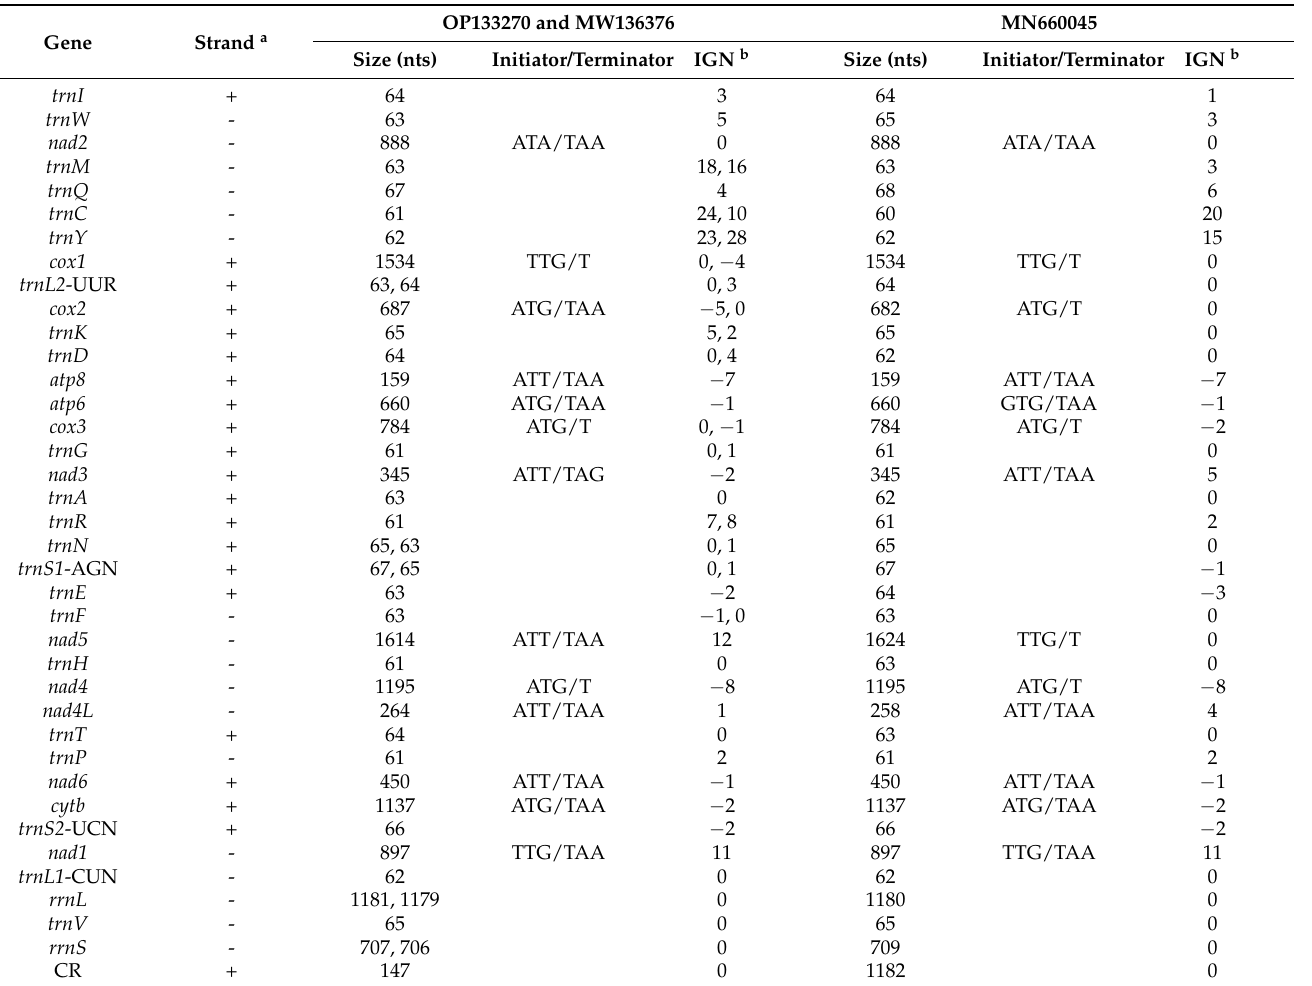
Table 1. Annotation of genes in three B. kugenumaensis mitogenomes from different locations.